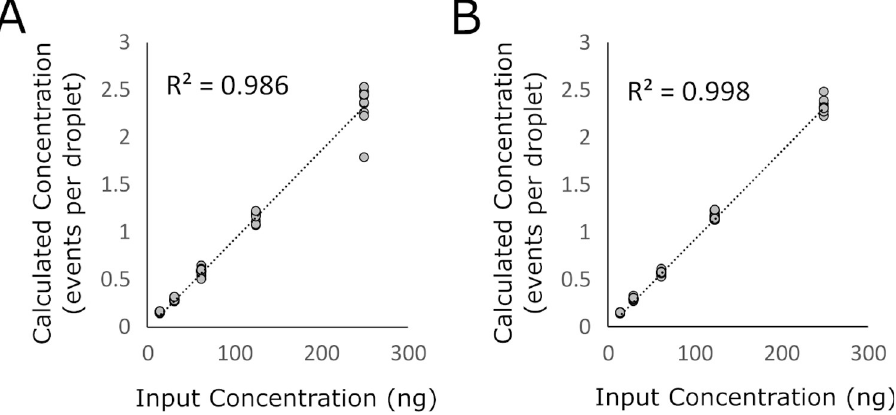
Fig 4. Linear correlation between input DNA concentration and experimentally calculated concentration for EGFR L858R reaction (A) and EGFR exon 19 deletion reaction (B).